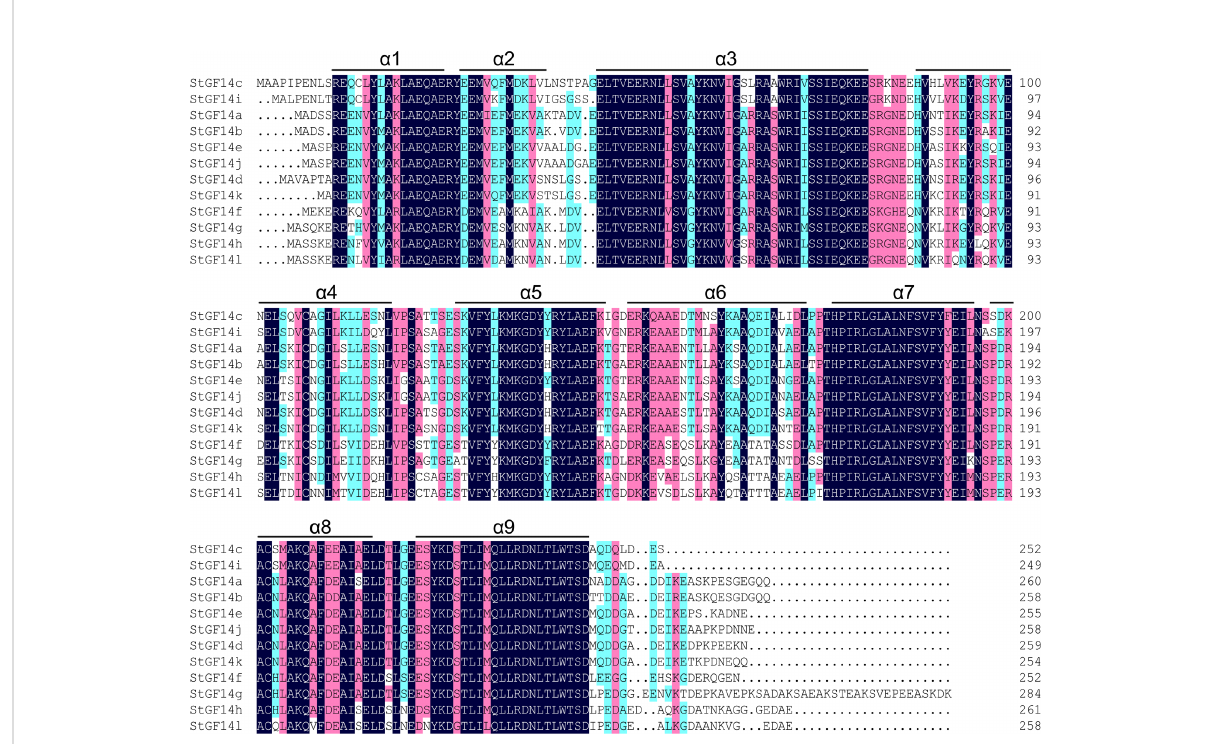
FIGURE 3 Sequences alignment of candidate potato 14-3-3 proteins. Amino acid sequences alignment of the twelve potato 14-3-3 proteins is performed using DNAMAN software. Nine a -helices were marked as a 1- a 9,